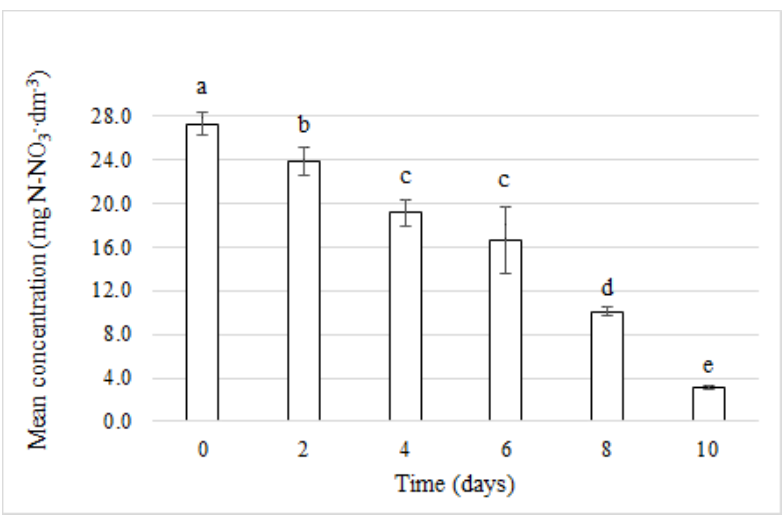
Figure 2. Changes in N-NO 3− concentration during cultures of Chlorella minutissima in wastewater (mean ± SD; ANOVA F (5, 48) = 327; p < 0.001; mean over each columns not marked with the same letter is significantly different at p < 0.001).